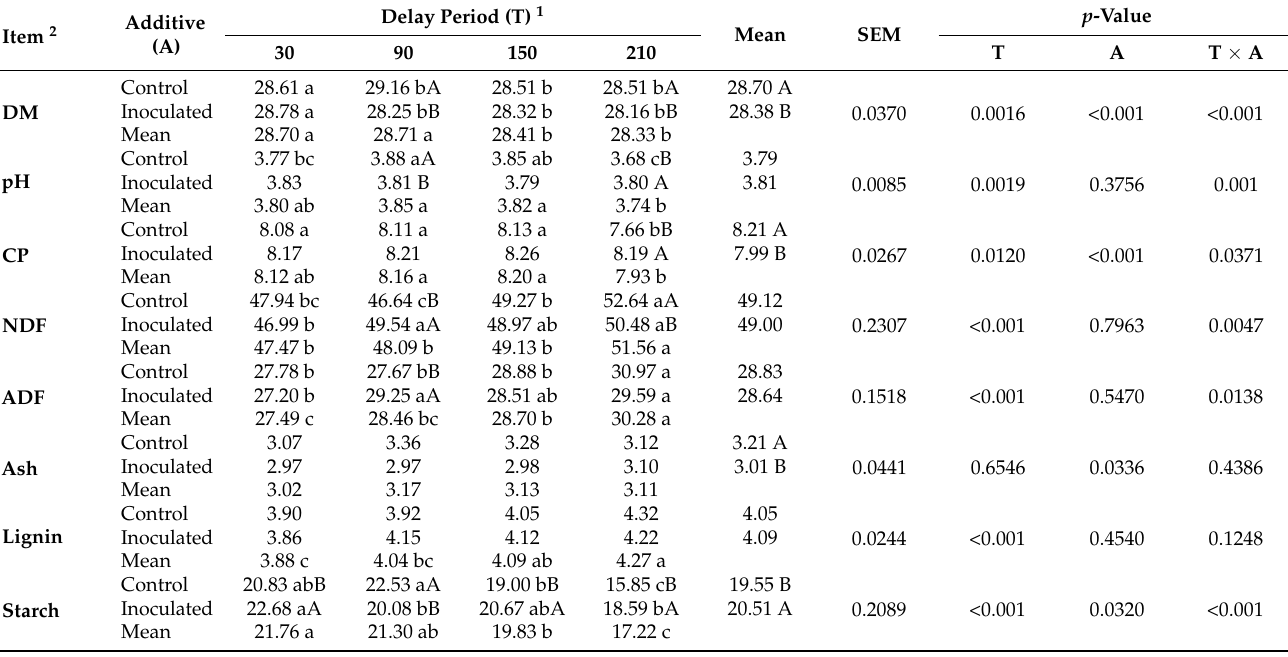
Table 1. Effects of delay period and inoculation on pH and chemical composition of